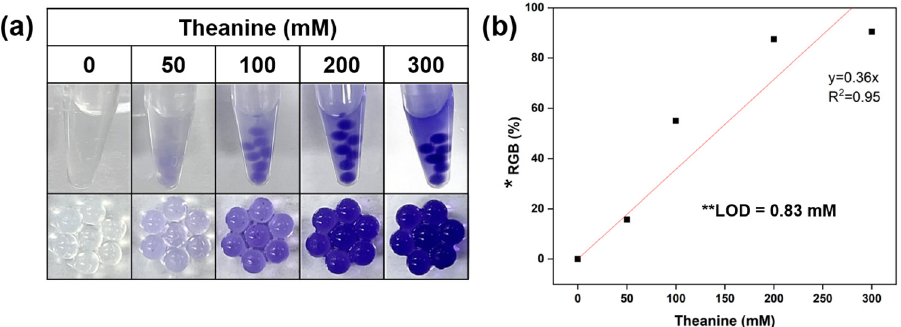
able microcapsules.